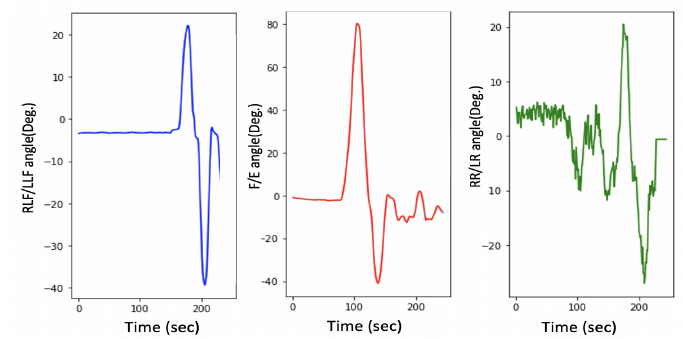
Figure 11. Head movement with a 9-axis IMU for typically developing child.